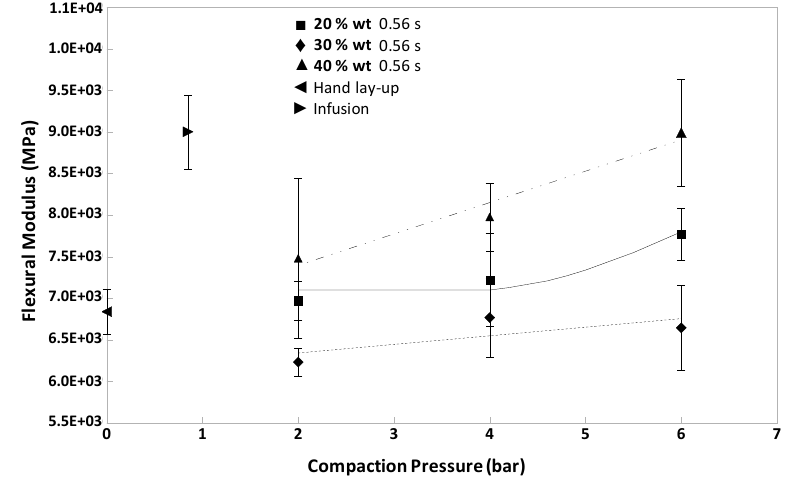
Figure 16. Flexural moduli of the composites with prepreg fibre contents of 20 ( ■ ), 30 ( ♦ ), and 40 wt.% ( ▲ ) and an initial exposure time of 0.56 s vs. the compaction pressure.